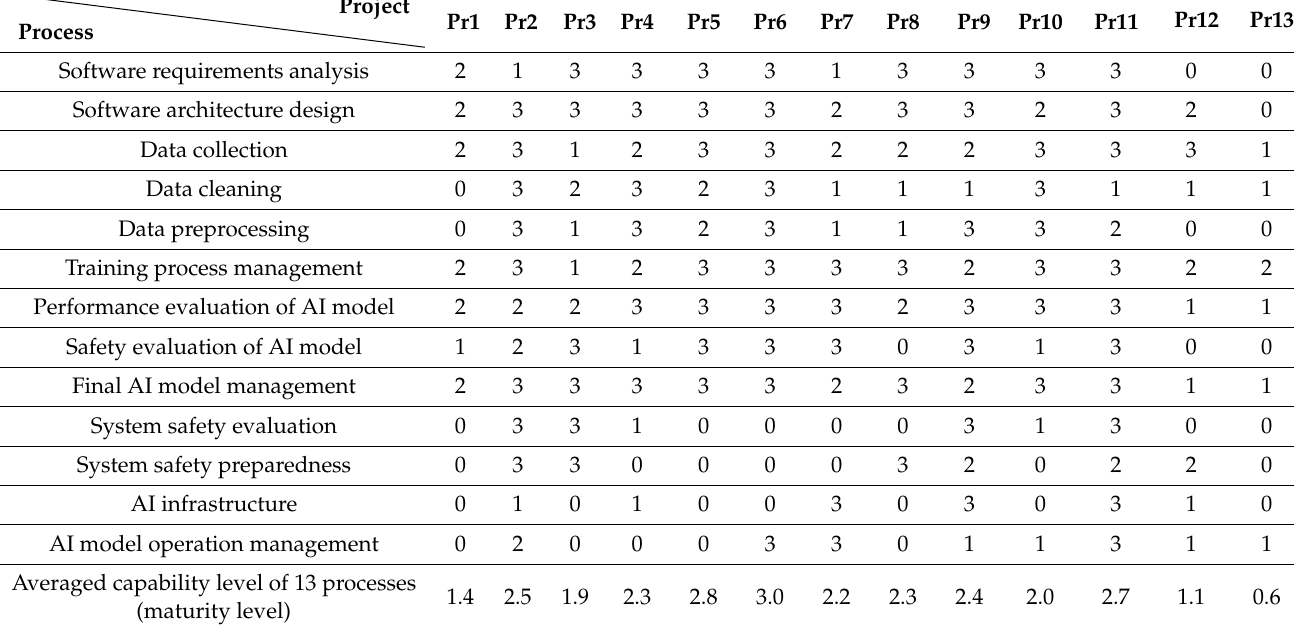
Table 6. Assessment results (capability levels) of applying AI-MM to 13 AI projects.